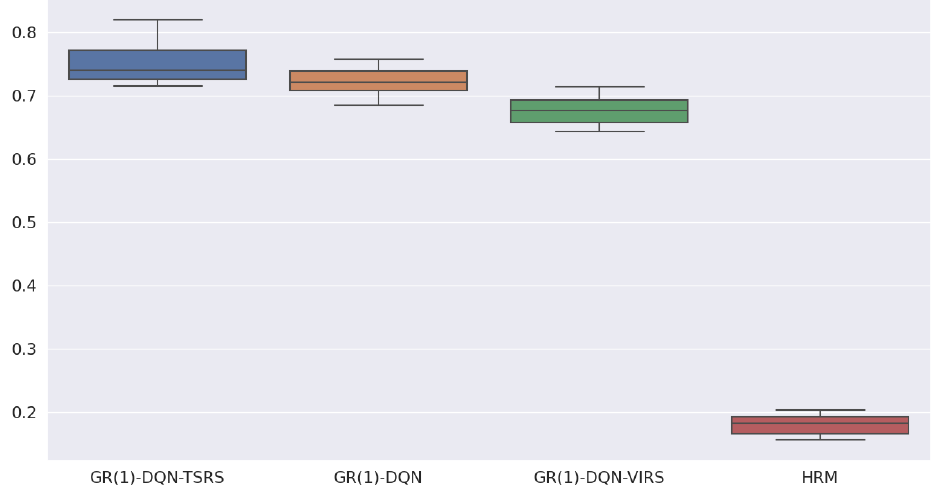
Figure 10. Box plot of learning curve for ϕ 3 under the same